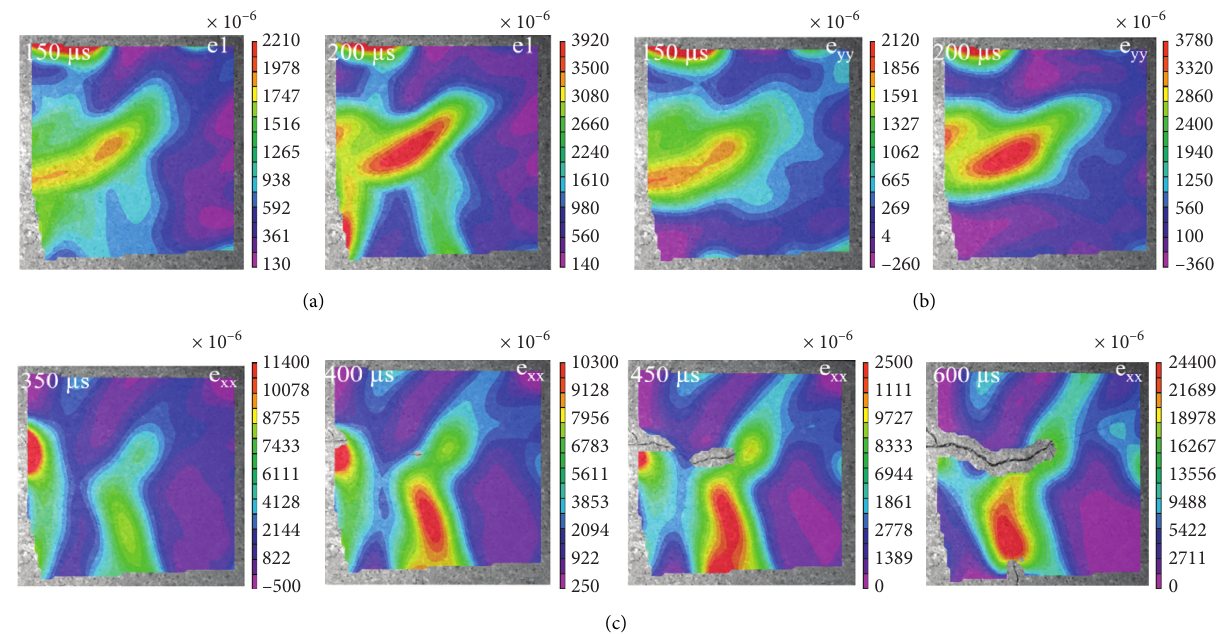
Figure 10: Full-field strain characterizations of crack initiation for test 2: (a) e 1; (b) e